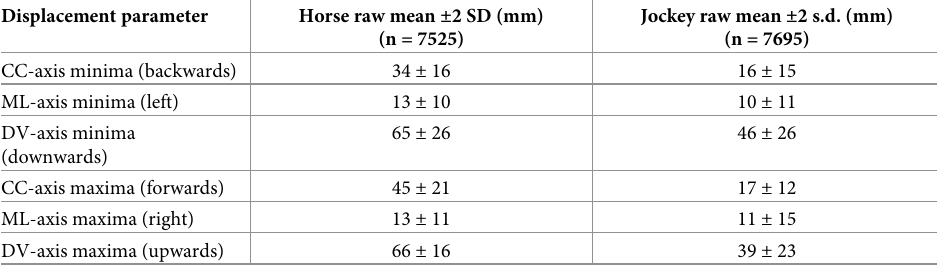
Table 2. Mean displacement minima and maxima based on collated stride